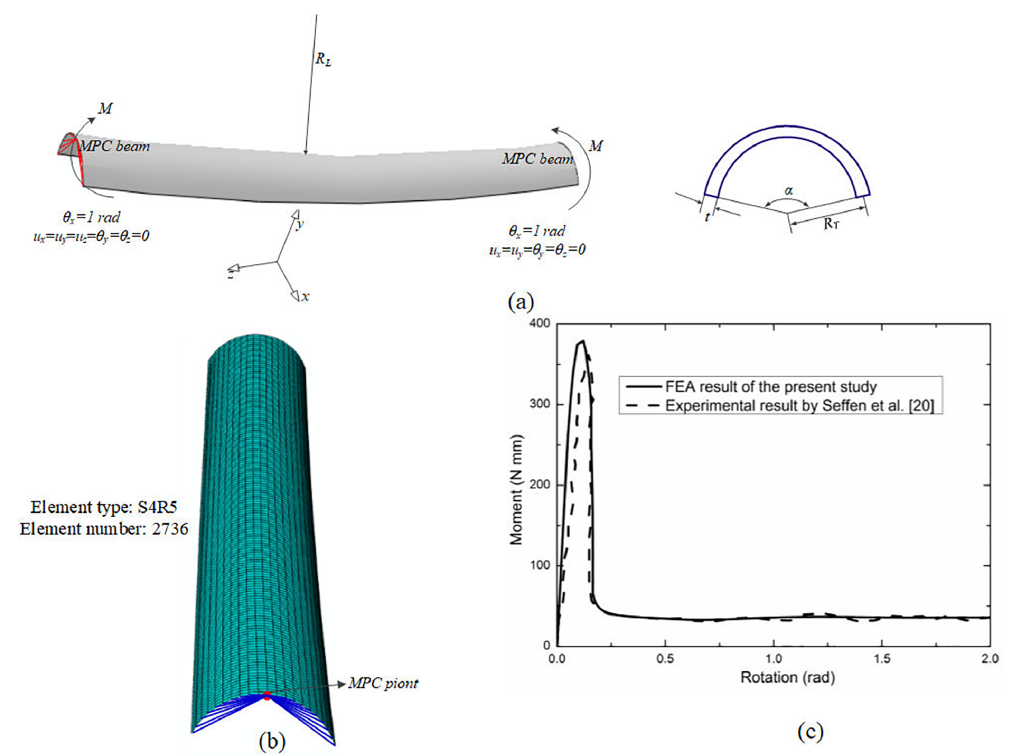
Figure 2. (a) Curved strip with negative Gaussian curvature and subject to a moment couple M > 0 at both ends and the boundary condition (left), and the cross-section of the strip (right), (b) the mesh and the boundary conditions of the strip, and (c) the moment-rotation relationship obtained from the finite element modelling of curved strip as compared to that by Seffen et al.